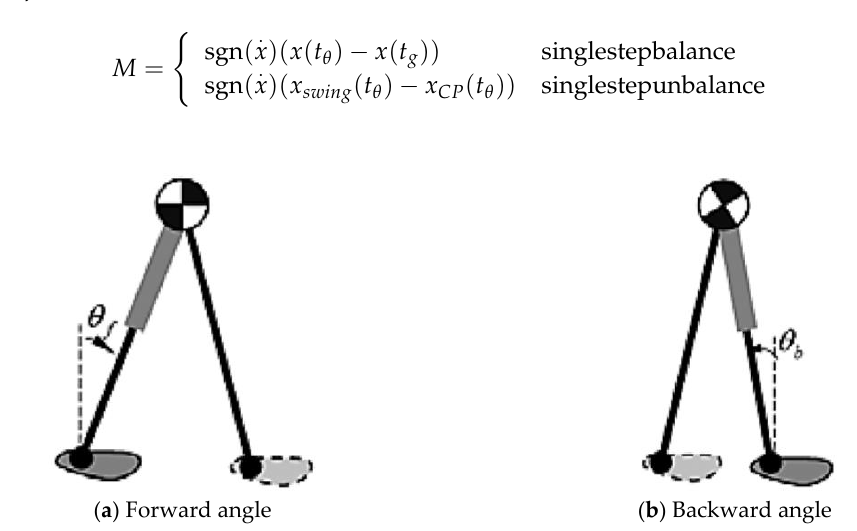
Figure 6. The angle between the support leg and the vertical direction.